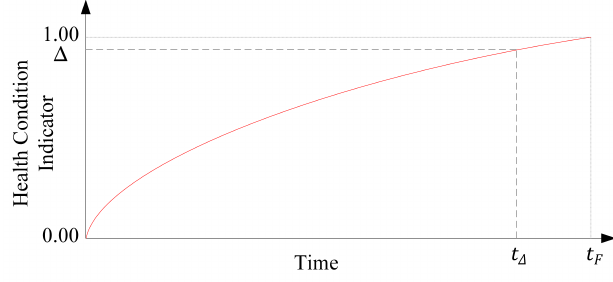
Figure 5. The defined anomaly model from the condition monitoring